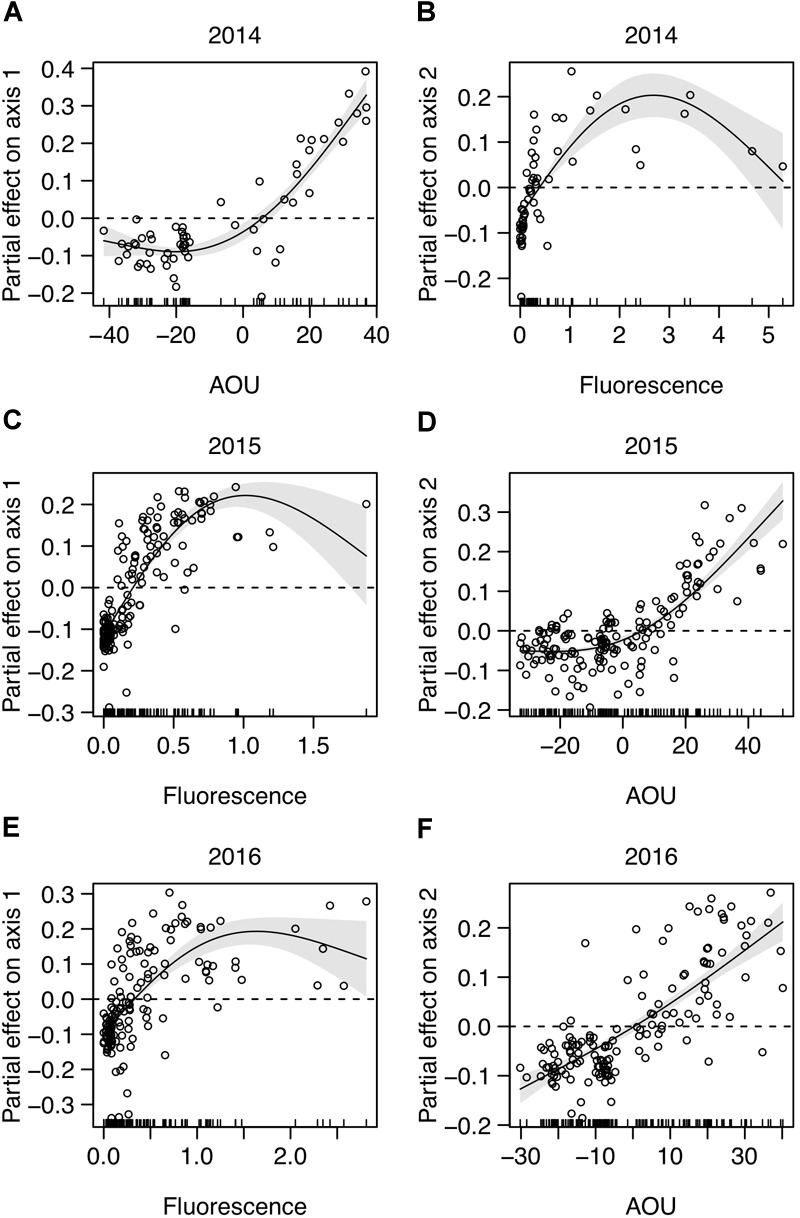
Environmental factors related to picoplankton community structure from the generalized additive models (GAM) (Table 2). Plots show the significant partial effect of the variable on (A,C,E) Axis 1 and (B,D,F) Axis 2 of NMDS analyses [dataset (iv)], computed for each year. Positive values indicate a positive effect of the variable on the NMDS Axis; negative values indicate a negative effect. Fitted regression line (solid), 95% confidence intervals (gray areas) and partial residuals are shown. NMDS plots and residual plots for each GAM model in Supplementary Figures S6, S7, respectively.